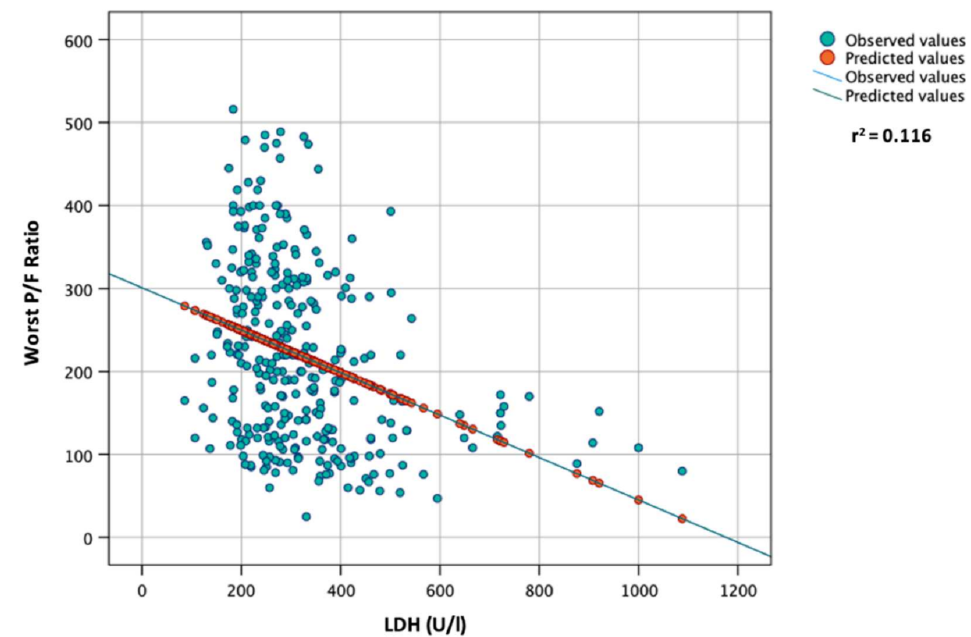
Figure 2. Linear regression analysis between worst P/F ratio during hospitalization (dependent) and LDH levels at